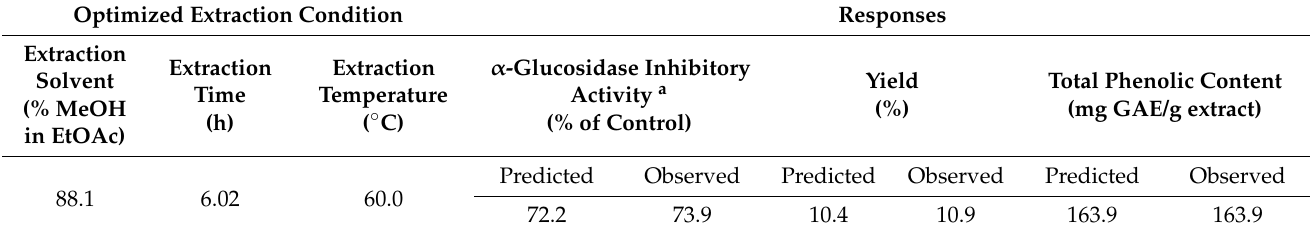
Table 5. Predicted and observed values of yield, total phenolic content and α -glucosidase inhibitory activity under optimized